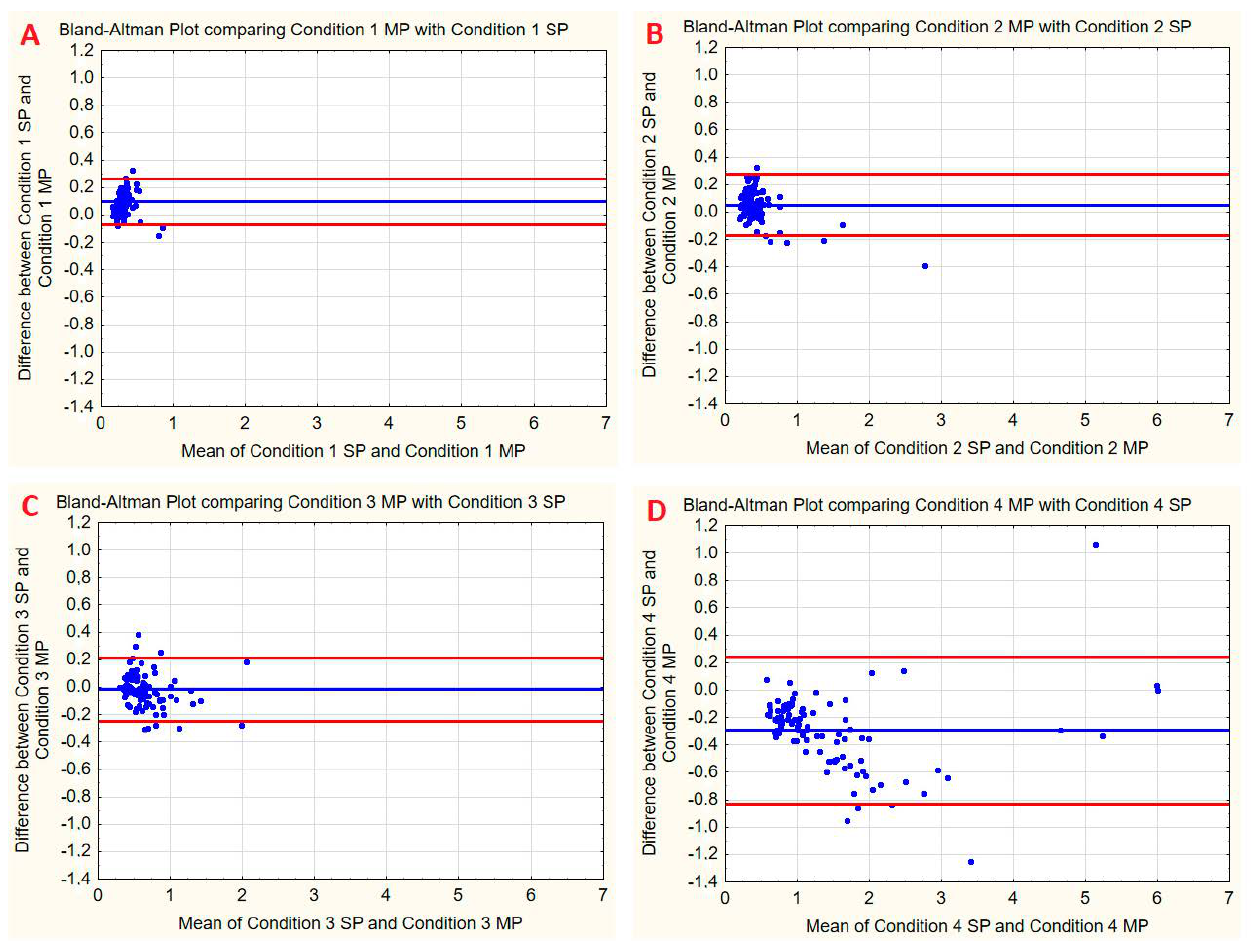
Figure 4. Bland–Altman plots for the mean difference of angular velocity measurement using two methods: mobile posturography with the MediPost and static posturography. Blue lines represent bias, red lines represent limits of agreement. ( A ) mCTSIB test condition 1. ( B ) mCTSIB test condition 2. ( C ) mCTSIB test condition 3. ( D ) mCTSIB test condition 4. SP- Static Posturography.